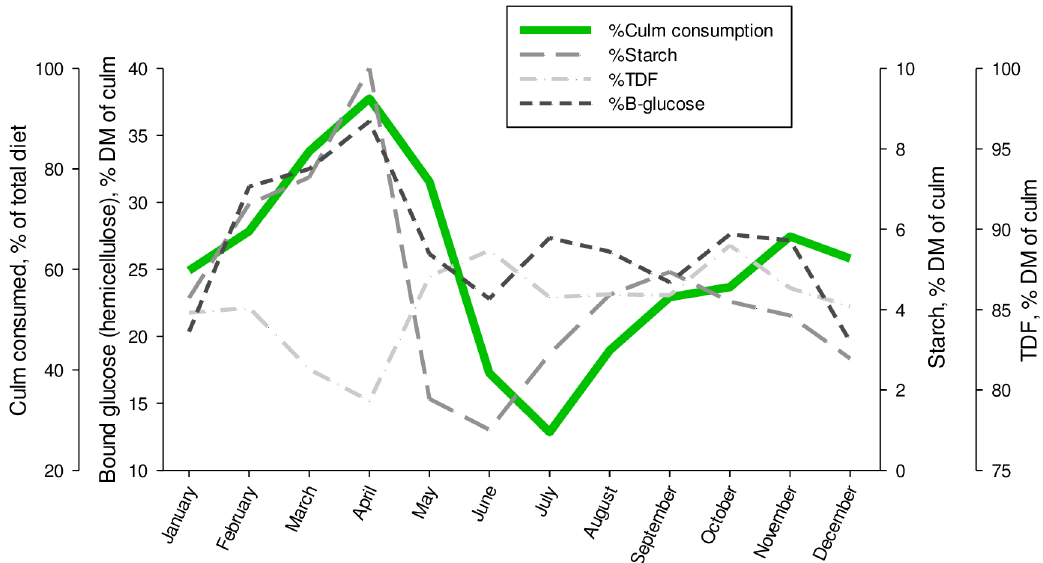
Fig 5. Annual changes in culm nutrients in relation to forage selection by giant pandas. Feedingbehaviordata for culm consumptionwere collectedat the same time as bamboowere collectedfor nutritionalanalyses, and reportedas the mean for both animalseach month. Bound glucose,starch, and fiber content in culm are shownas the mean of four Phyllostachys species duringeach month of the year. Nutritional data are presentedon a dry matter (DM) basis.